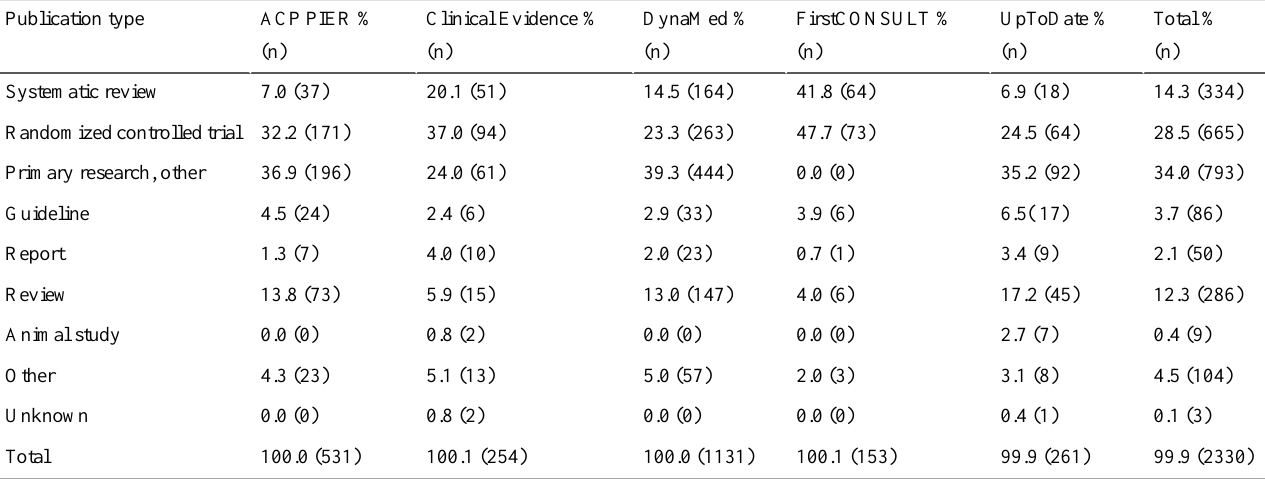
Table 3. Detailed analysis of publication types by point-of-care product (may not total 100% due to